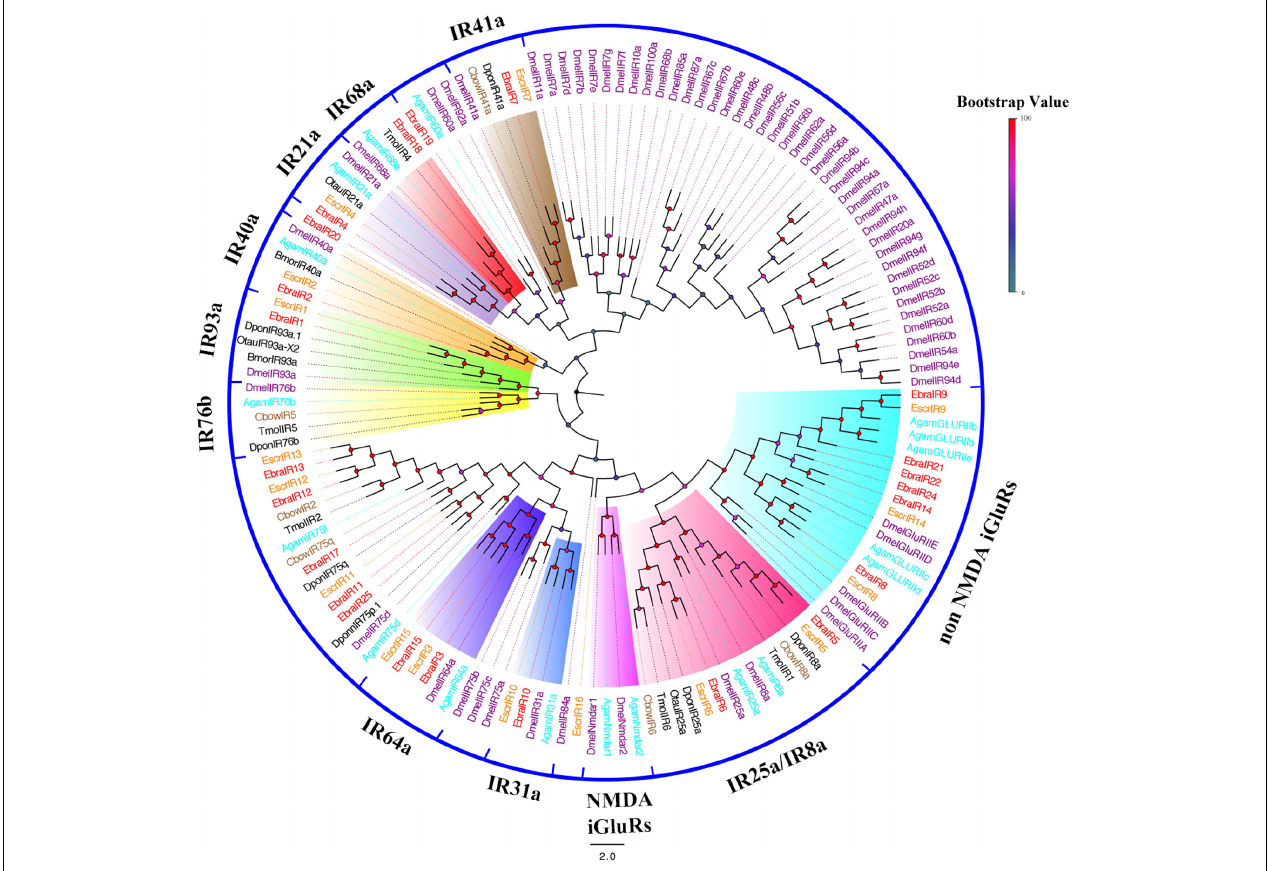
FIGURE 4 | Phylogenetic tree of putative ionotropic receptor (IR) genes. The E. scrobiculatus genes are shown in yellow and E. brandti genes are shown in red. The tree was constructed using MEGA6 with Neighbor-joining method. Amino acid sequences used for the tree are listed in Supplementary Table S10